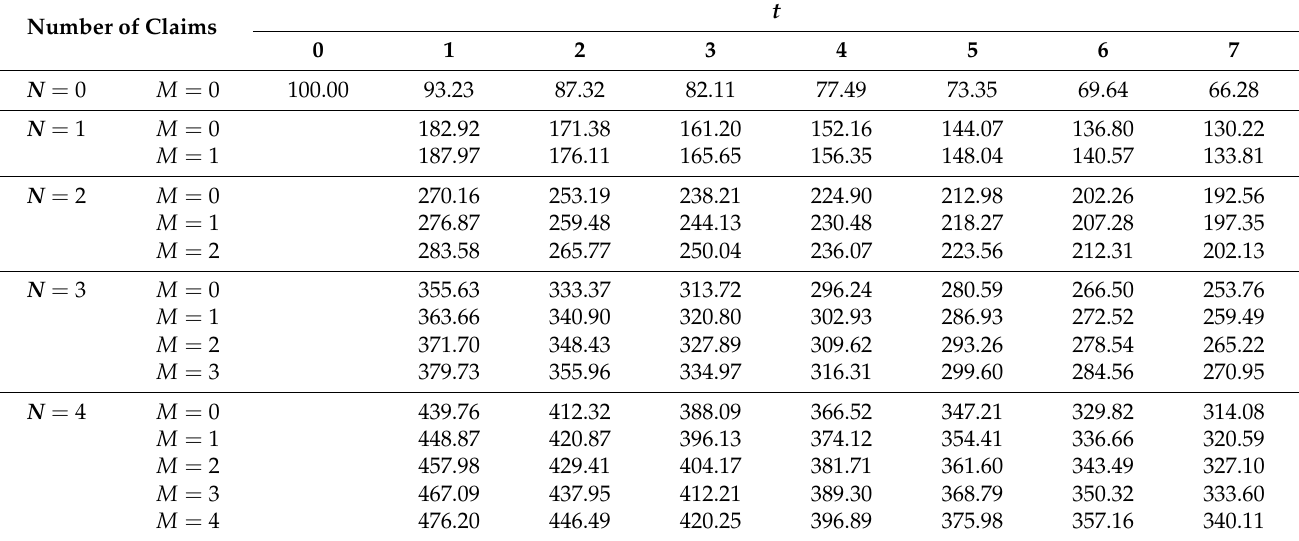
Table 3. Bonus-malus premiums based on the Poisson binomial-Lindley beta distribution for the frequency component where N represents the total number of claims and M represents those that the claim size is larger than Φ = 500.